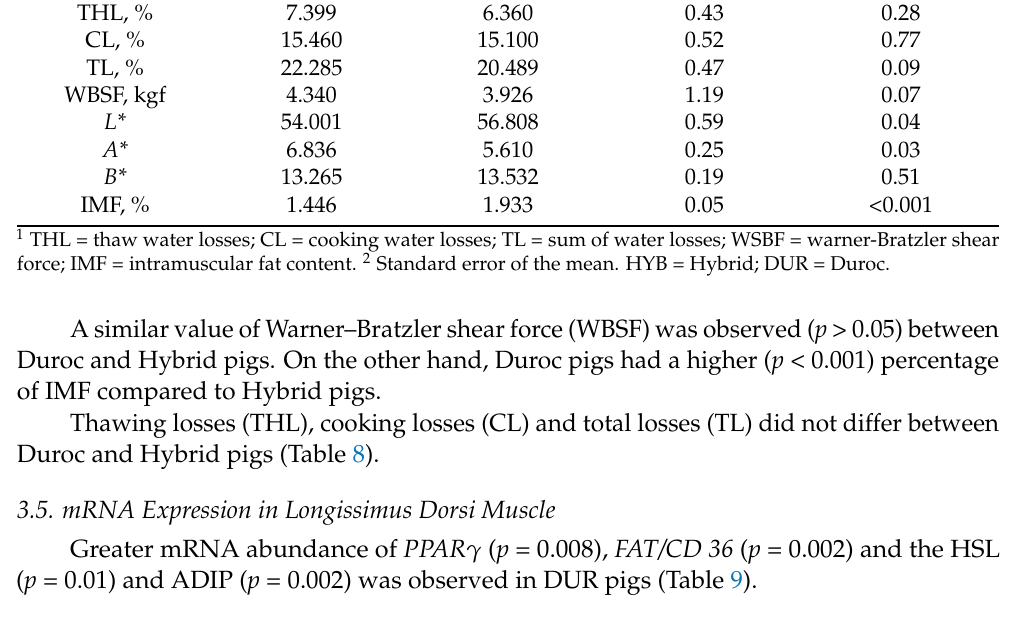
Table 9. mRNA expression in the LD muscle of pigs of different genetic